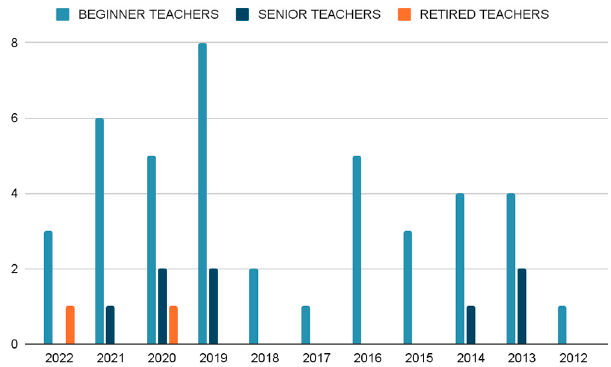
Figure 5. Year of publication of the selected articles.